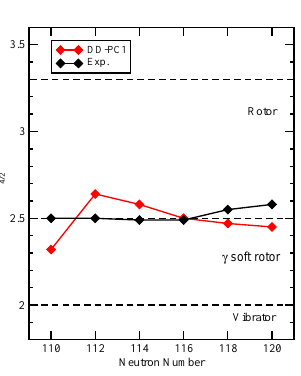
Figure 3: The ratio R 4 / 2 of excitation energies of the yrast states 4 + and 2 + as a function of the neutron number in 1 1 even-even 190 − 200 Hg isotopes calculated using the 5DCH model based on the DD-PC1 functional. The experimental data are taken from Ref. [21]